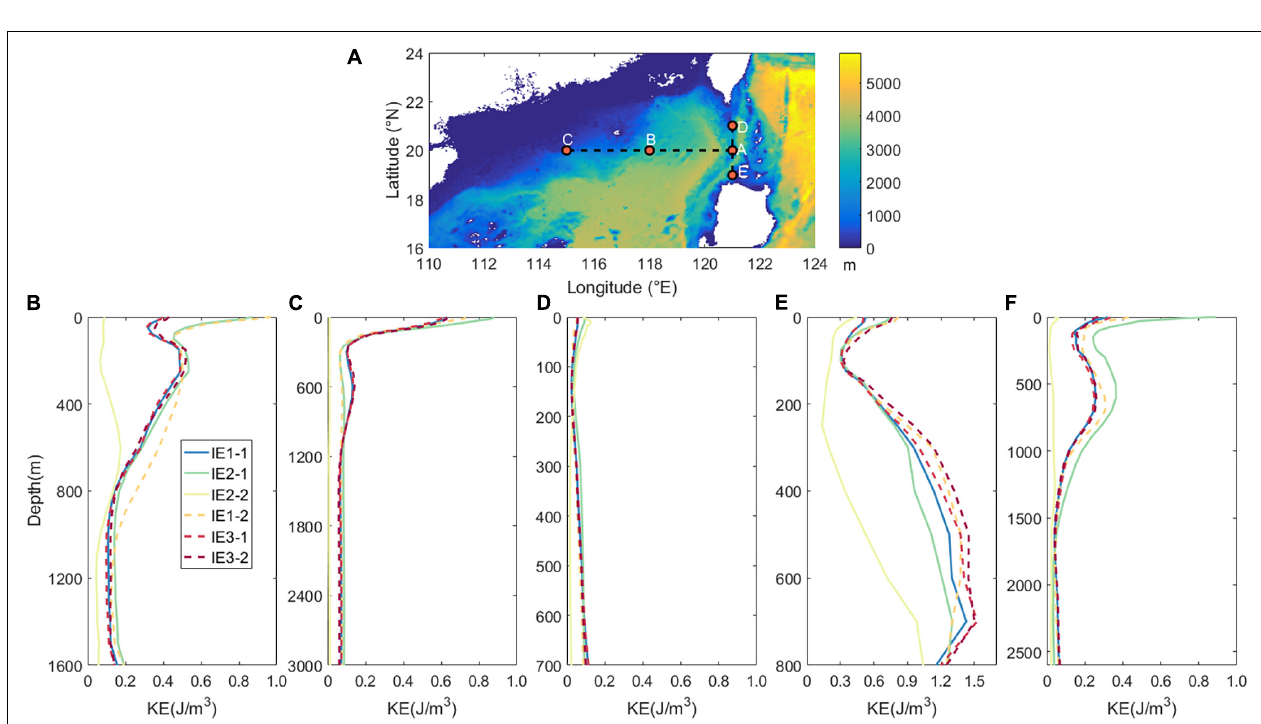
FIGURE 10 | Eastward velocities of semidiurnal baroclinic tides (black solid line), coherent signals (blue dashed line), and incoherent signals (red dot line) at the depth of 100 m for experiments in (A,B) IE1, (C,D) IE2, and (E,F) IE3 at site C.